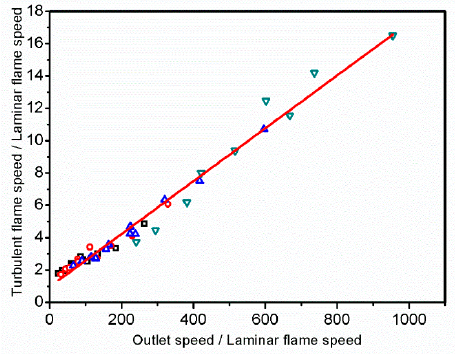
Figure 17. Relationship between the ratio of turbulent flame velocity to laminar flame velocity and the ratio of outlet flow velocity to laminar flame velocity for the same composition of syngas.